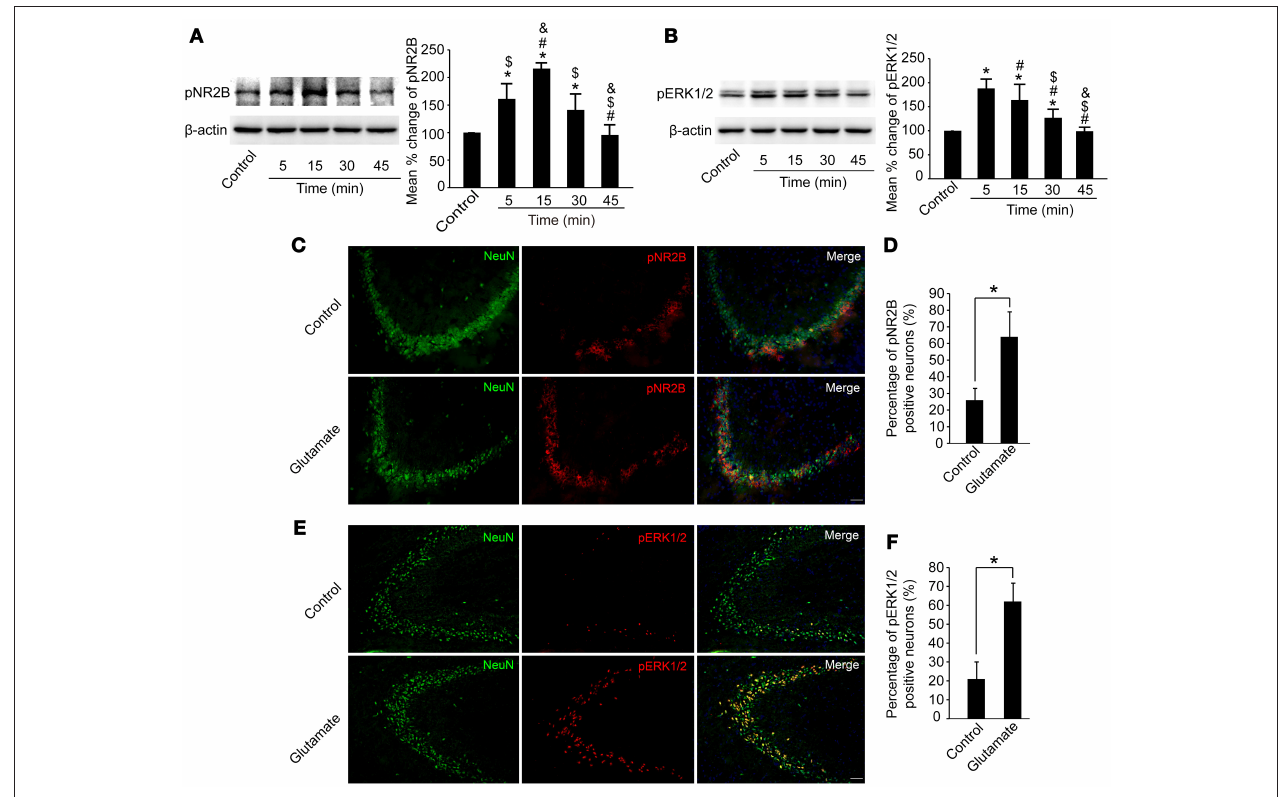
FIGURE 5 | Glutamate injections upregulated pNR2B and pERK1/2 expression in the hippocampus. OVX rats were assigned to 5 groups for western blot analyses. At 5, 15, 30, and 45min following the glutamate injections, rats were sacrificed and the intact hippocampus was dissected. In addition, in control group, we eliminated the possibility that the needle insertion produced protein expression changes by sacrificing rats immediately after vehicle injections. (A,B) Representative western blot of pNR2B and pERK1/2 after glutamate injections. Quantification of protein levels was normalized against loading control β -actin and presented as the relative density compared with the control group. * P < 0.05 vs. control group; # P < 0.05 vs. 5min group; $ P < 0.05 vs. 15min group; & P < 0.05 vs. 30min group; n = 5, per group. OVX rats were assigned to three groups for immunohistofluorescence staining: (1) rats received isotonic saline injections and were sacrificed immediately for pNR2B and pERK1/2 staining, (2, 3) rats received glutamate injections and were sacrificed respectively after 15min for pNR2B and 5min for pERK1/2 staining. (C,E) Representative fluorescence photomicrographs showing pNR2B and pERK1/2 positive neurons in CA3 of the hippocampus after glutamate injections. Scale bar = 50 µ m. (D, F) The percentages of pNR2B and pERK1/2 positive neurons post-glutamate injections; * P < 0.05; n = 4, per group. pNR2B, phosphorylated NR2B subunit of the N-methyl-D-aspartate receptor; pERK1/2, phosphorylated (p44/42) mitogen-activated protein